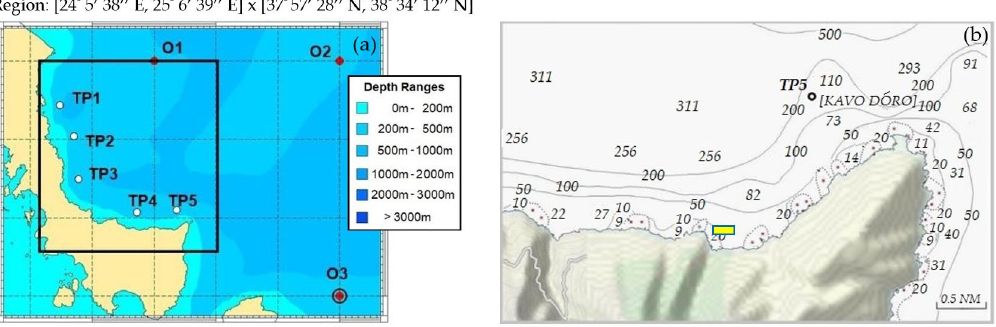
Figure 5. ( a ) Nearshore area considered for the FPV deployment in western Pagasitikos Gulf region. ( b ) Calculated waves using SWAN model for the following offshore data: H s = 0.42 m, T e = 4.44 s, mean wave direction = 141°, wind speed = 6.33 m/s, wind direction = 180°. The position of the considered FPV structure is shown by using yellow rectangle.